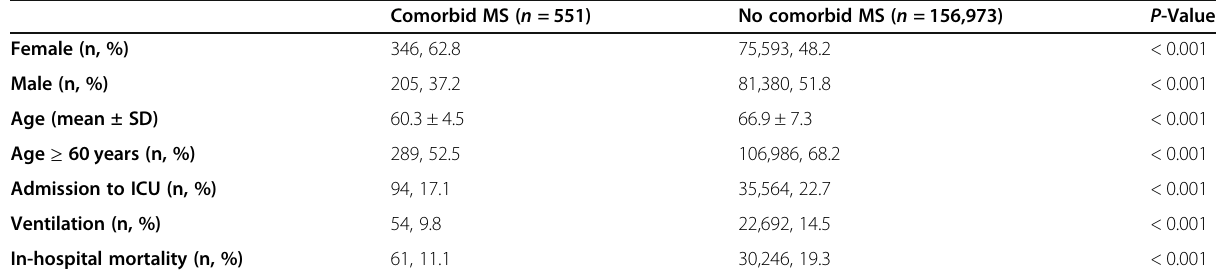
Table 1 General characteristics of COVID-19 patients stratified by the presence of comorbid